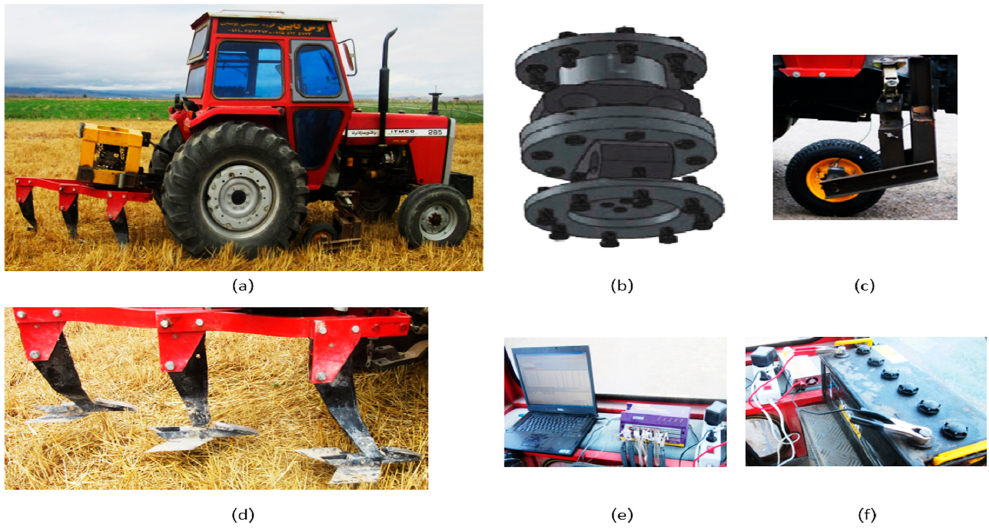
Figure 2. ( a ) The mechanism used for field experiments includes: ( b ) the three-point connection dynamometer to measure the force applied to devices; ( c ) fifth wheel mechanism for measuring real progressive speed; ( d ) para-plow with the backward wings; ( e ) data logger and laptop for data recording; ( f ) the battery built into the cabin to power the data logger and